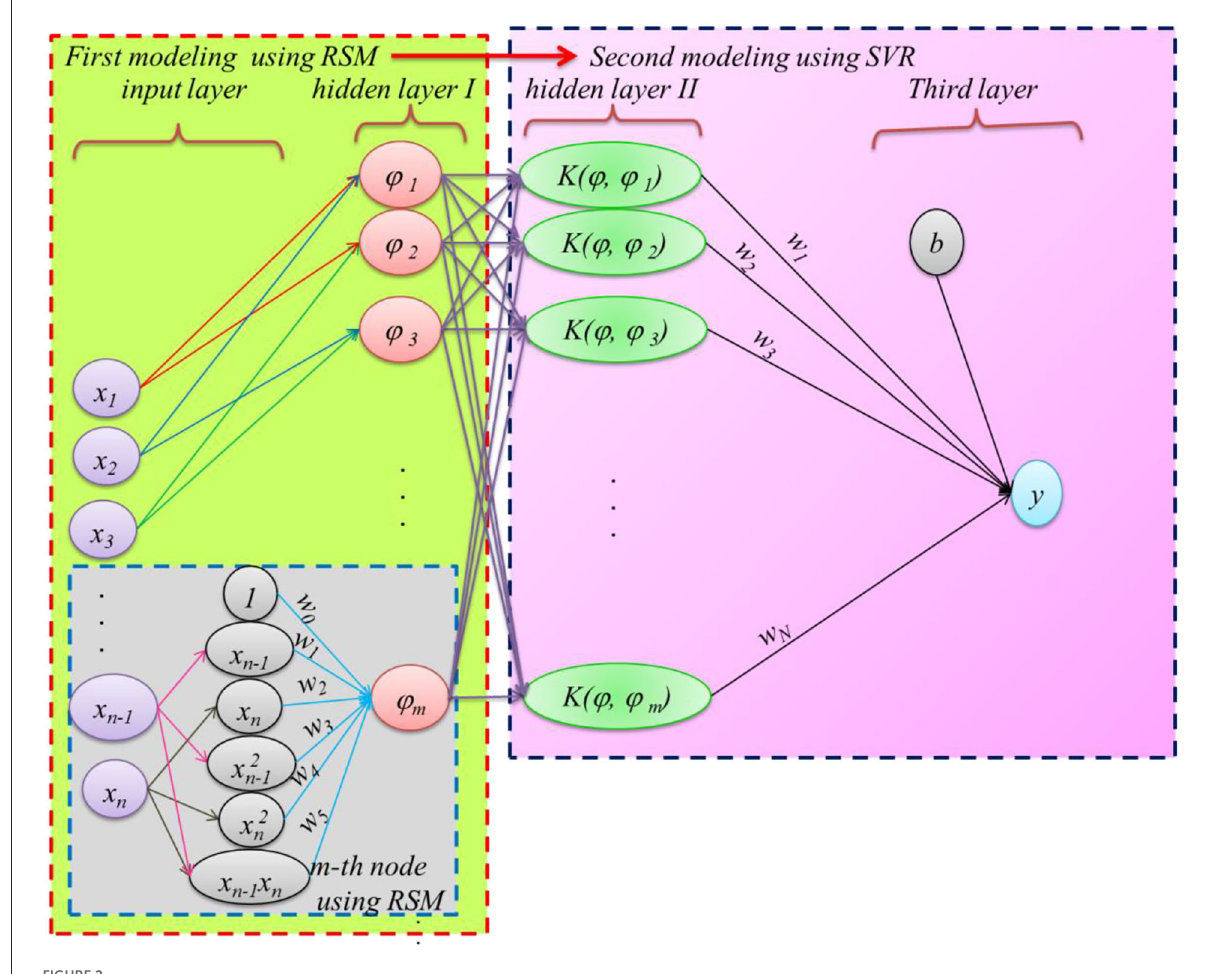
FIGURE2 A view of RSM-SVR.